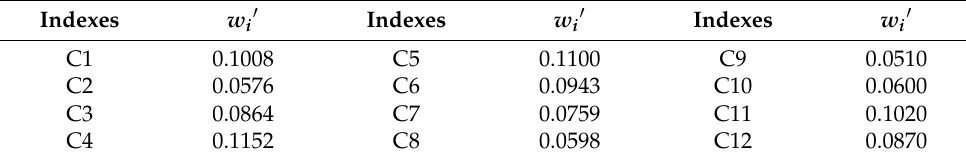
Table 3. Calculation results of subjective weight ( w i (cid:48) ) of AHP.